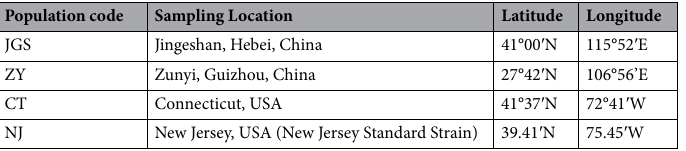
Table 7. Location information for the four sampling sites of the spongy moth, Lymantria